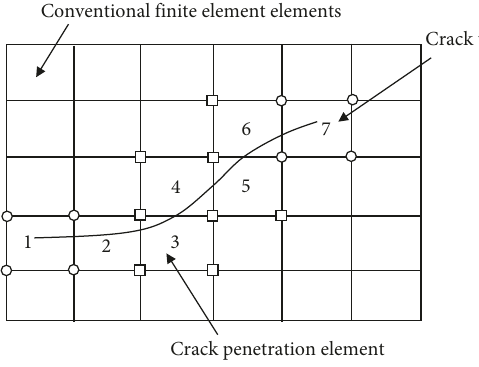
Figure 1: Element grid of